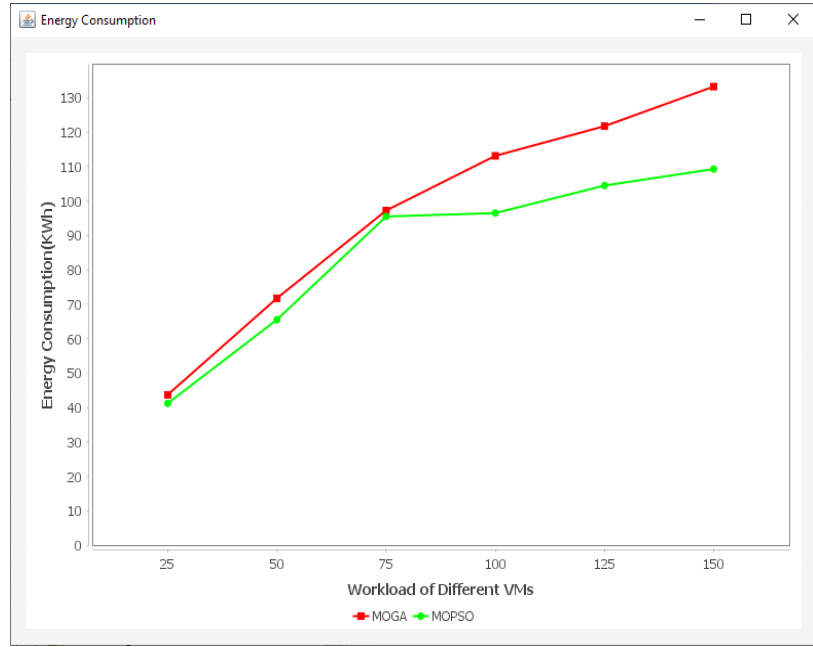
Figure 6. Energy consumption. Table 4. Energy consumption evaluation for MOGA and MOPSO.